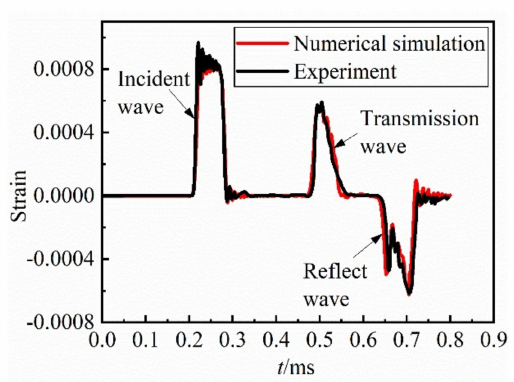
Figure 24. Strain time history curve of Indian limestone obtained using conventional SHPB (initial velocity of striker bar is 8.05